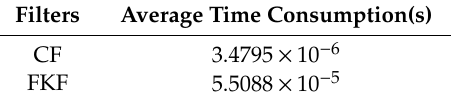
Table 3. Time consumptions of CF and FKF.